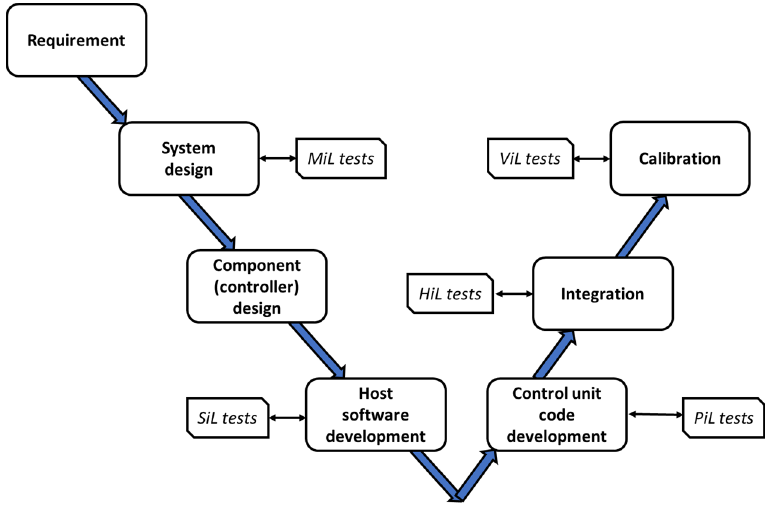
Figure 1. The “V” development process composed of various testing phases.